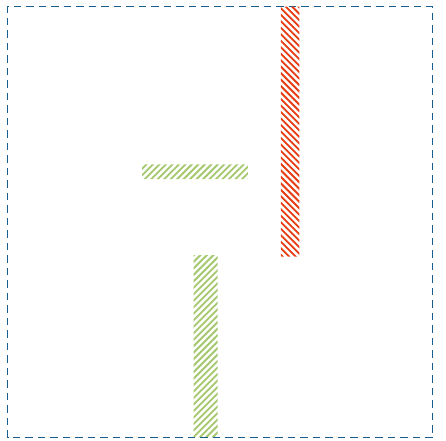
Figure 6: XOR of the two clips